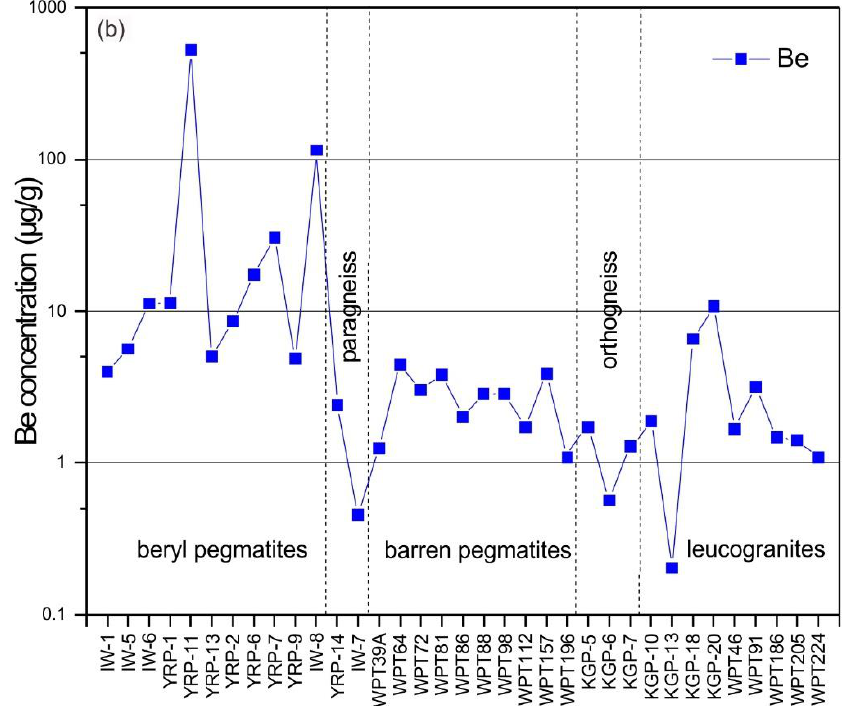
Figure 6. Concentration profiles of ( a ) Li-, Cs-, Nb-, Ta-; ( b ) Be- in pegmatites, gneiss, and granites from Eastern Nepal, Higher Himalaya.